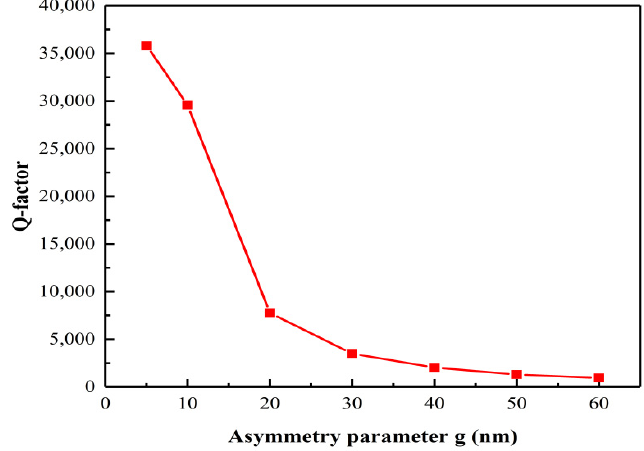
Figure 3. Q-factor of F3 with different asymmetric parameters.